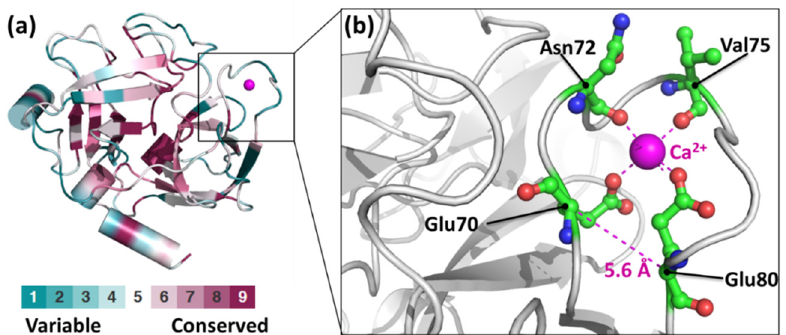
Figure 1. Level of conservation and localization of the CBL of trypsin. ( a ) Illustration of the degree of conservation of trypsin. Highly conserved residues are shown in red and variable residues are shown in blue. ( b ) Depiction of the CBL of anionic rat trypsin II. The coordinating residues Glu70, Asn72, Val75, and Glu80 are shown in green and the stick form. Additionally, electrostatic interactions, as well as Ca 2+ , are shown in magenta. For analysis and the depiction, the pdb-file 1ITZ was used.